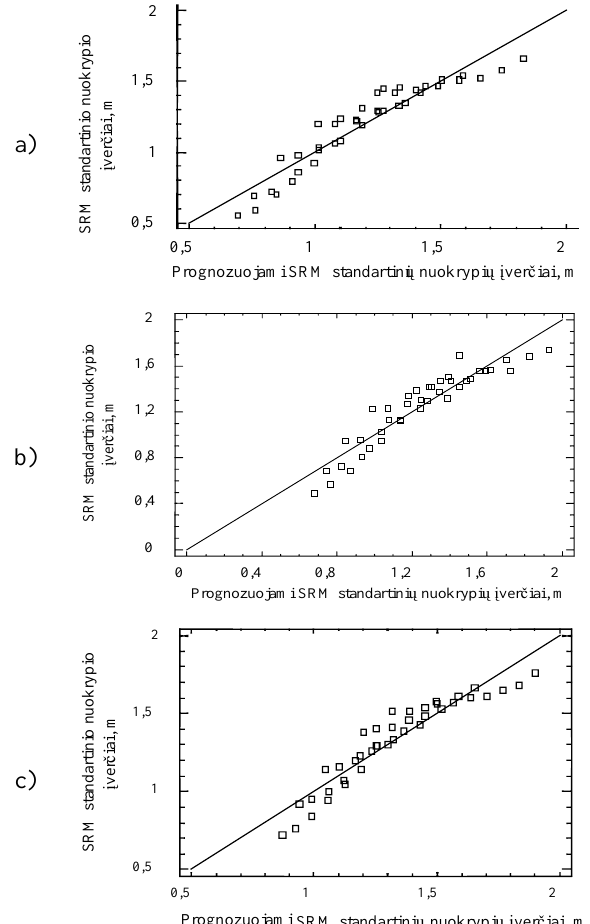
atstumus tarp aukš č i ų tašk ų , skai č iavimas: a) krigingo metodas; b) splaino metodas; c) svorinis metodas Fig 1 . Calculation of regression results, evaluating by cell and distance between the high points: a) kriging method; b) spline method; c) IDW